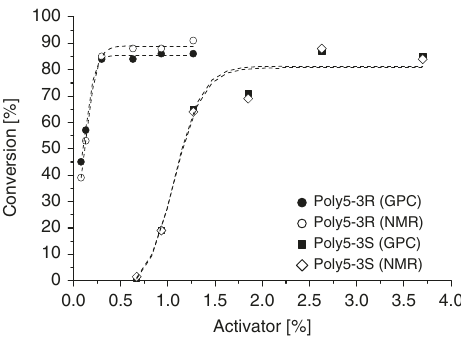
Fig. 5 NMR and GPC investigations of the monomer conversion. Conversion of the lactams and illustrative sigmoidal Boltzmann Fit depending on an increasing amount of activator Bz5-3S determined by NMR and GPC (Supplementary Figs. 11 – 16, Supplementary Table